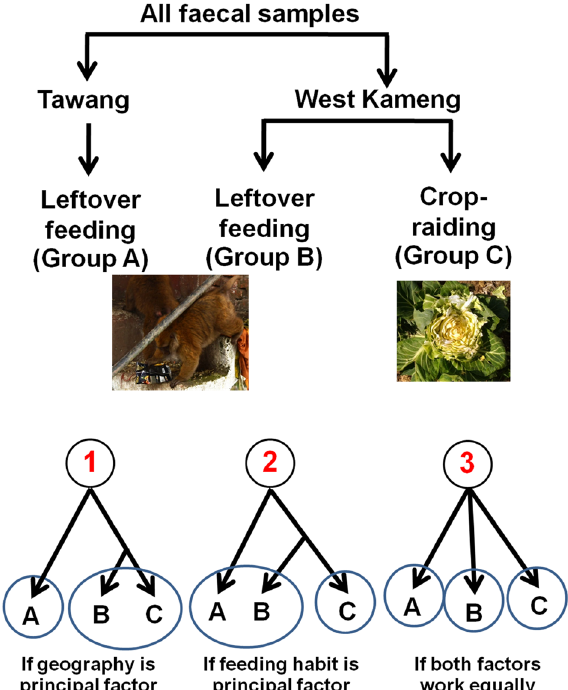
Figure 1. Schematic diagram of the study design and hypothesis of the present study. Three probable scenarios illustrated according to geographical origin of the samples and feeding behaviour of the study